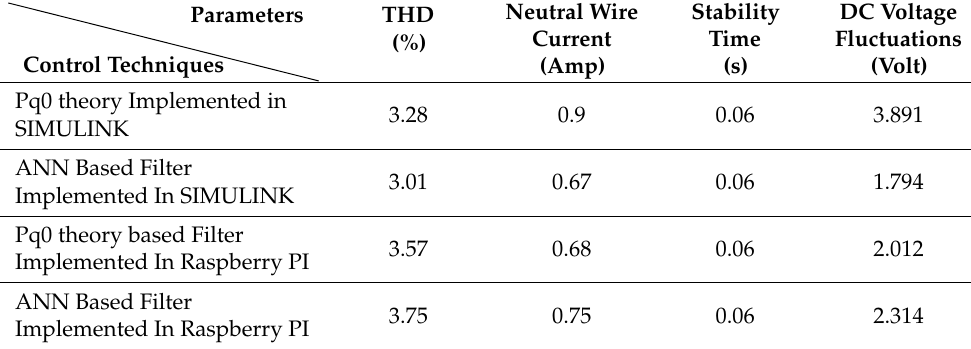
Table 4. Comparative Analysis.